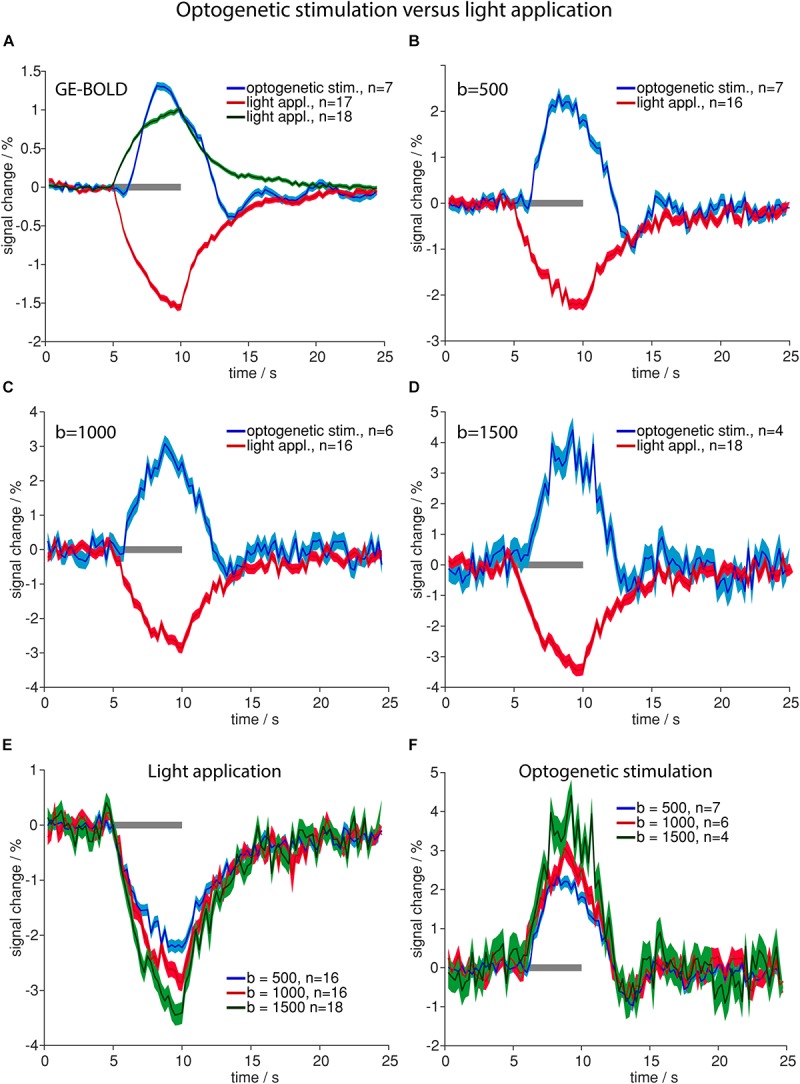
Comparison of high-intensity light application and optogenetic stimulation. (A–D) Averaged time courses upon optogenetic stimulation (blue line in A–D) and light application (positive changes in green in A, negative changes in red in A–D) for GE-BOLD (A), diffusion with b = 500 s/mm2
(B), diffusion with b = 1000 s/mm2
(C) and diffusion with b = 1500 s/mm2
(D) are shown. Signal change upon light application begins with the stimulation and signal rises until stimulation stops. In contrast, signal change upon optogenetic stimulation begins delayed and reaches its peak before the end of stimulation. (E) Averaged signal changes upon high-intensity light application for diffusion sequences with b = 500 s/mm2 (blue), 1000 s/mm2 (red) and 1500 s/mm2 (green) are shown. (F) Averaged signal changes upon optogenetic stimulation for diffusion sequences with b = 500 s/mm2 (blue), 1000 s/mm2 (red) and 1500 s/mm2 (green) are shown. In both, (E,F), amplitude rises with increasing diffusion weighting. All time courses were acquired with TR 250 ms. Gray bars indicate stimulation periods, mean ± SEM is shown, n indicates number of measurements. All mean time courses are based on time courses extracted with the GLM analysis. High-intensity light application was always performed in naïve animals that did not express opsins.